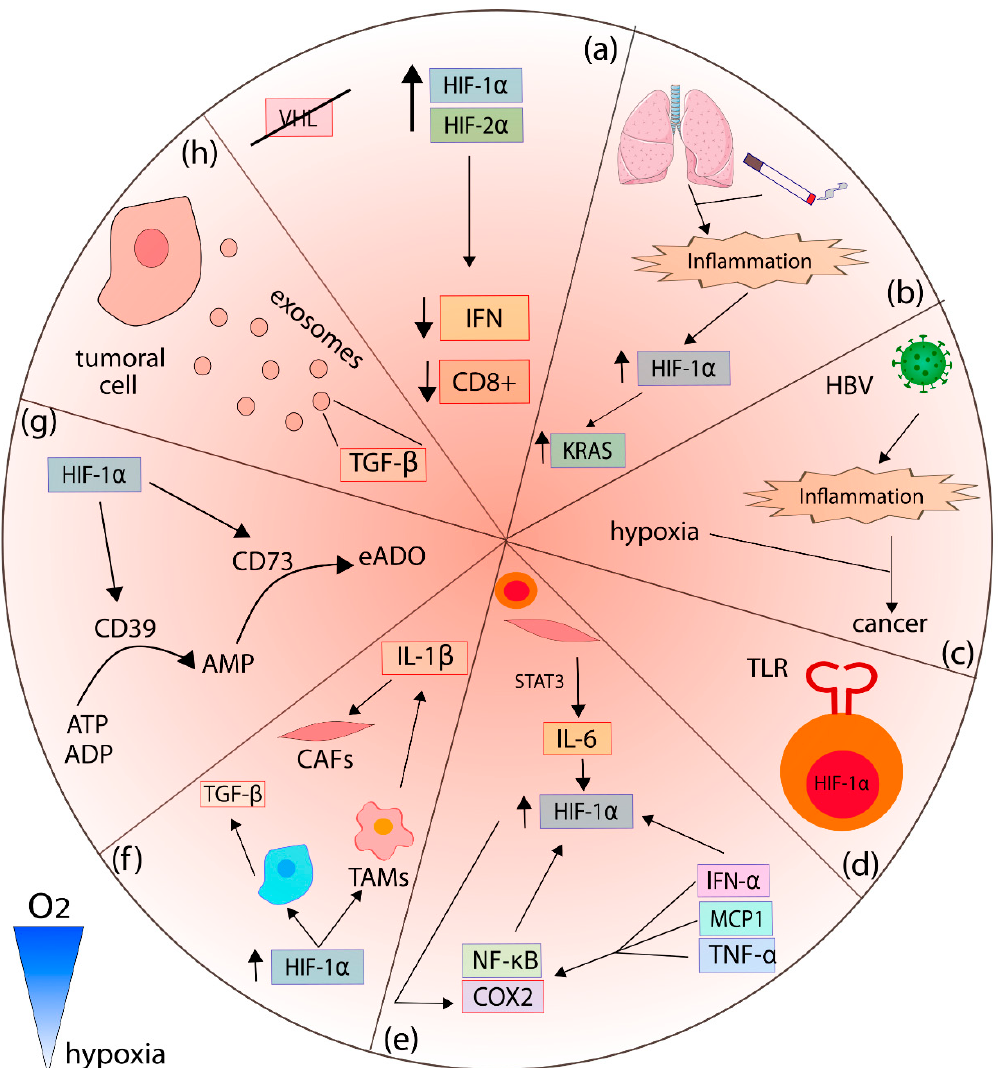
Figure 2. Interrelation between the HIF pathway, inflammation, and cancer. ( a ) In ccRCC, VHL is inactive, leading to HIF-1 α and HIF-2 α accumulation. As a consequence, there is a decrease in antitumoral response due to low levels of HIF-1 α , IFN, and CD8+ inactivated cells. ( b ) Inflammation- induced by COPD with the overexpression of HIF-1 α leads to overactivation of KRAS signaling and cancer. ( c ) Viruses such as HBV also induce inflammation that synergizes with hypoxia as factors to induce cancer. ( d ) Correlation between the expression of TLR and nuclear HIF-1 α was observed in early carcinogenesis of the pancreas. ( e ) IL-6, NF- κ B, and IFN- α induce the overexpression of HIF-1 α ; indirectly, TNF- α and MCP1 also induce HIF-1 α through the NF- κ B/COX2 axis. HIF-1 α also induces the expression of COX2. ( f ) HIF-1 α stimulates TAMs and tumoral cells to release IL-1 β , which stimulates CAFs. Tumoral cells also secrete TGF- β . ( g ) HIF-1 α induces and regulates the expression of CD39 and CD73 to obtain eADO. ( h ) Hypoxic tumoral cells release exosomes enriched with molecules, such as TGF β -inducing M2 TAMs recruitment. Abbreviations: clear cell renal cell carcinoma, ccRCC; chronic obstructive pulmonary disease, COPD; hepatitis B virus, HBV; toll-like receptors, TLR; interleukin 1-beta, IL-1 β ; tumor necrosis factor- α , TNF- α ; interferons, IFN; monocyte chemoattractant protein 1, MCP1; extracellular adenosine, eADO. See more details in the main text. Lung icon of Figure 2b is from Servier Medical Art. Servier Medical Art by Servier is licensed under a Creative Commons Attribution 3.0 Unported License (https://creativecommons.org/licenses/by/3.0/, accessed on 2 January 2022).